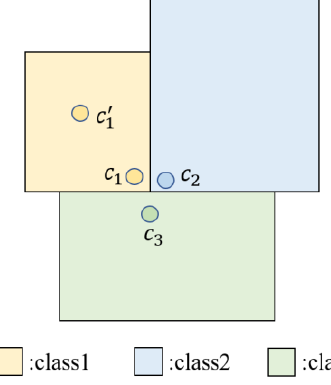
Figure 7. Junction of multiple objects.